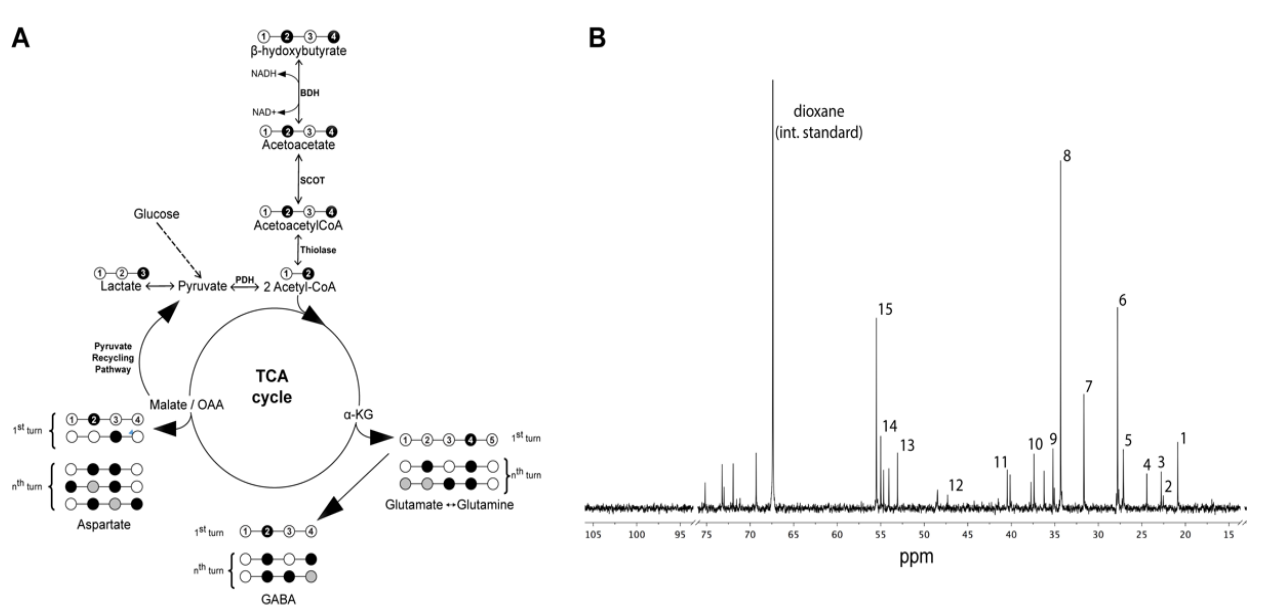
13 C]acetyl CoA. Acetyl CoA labeled in the C2 position enters the TCA cycle, giving rise to